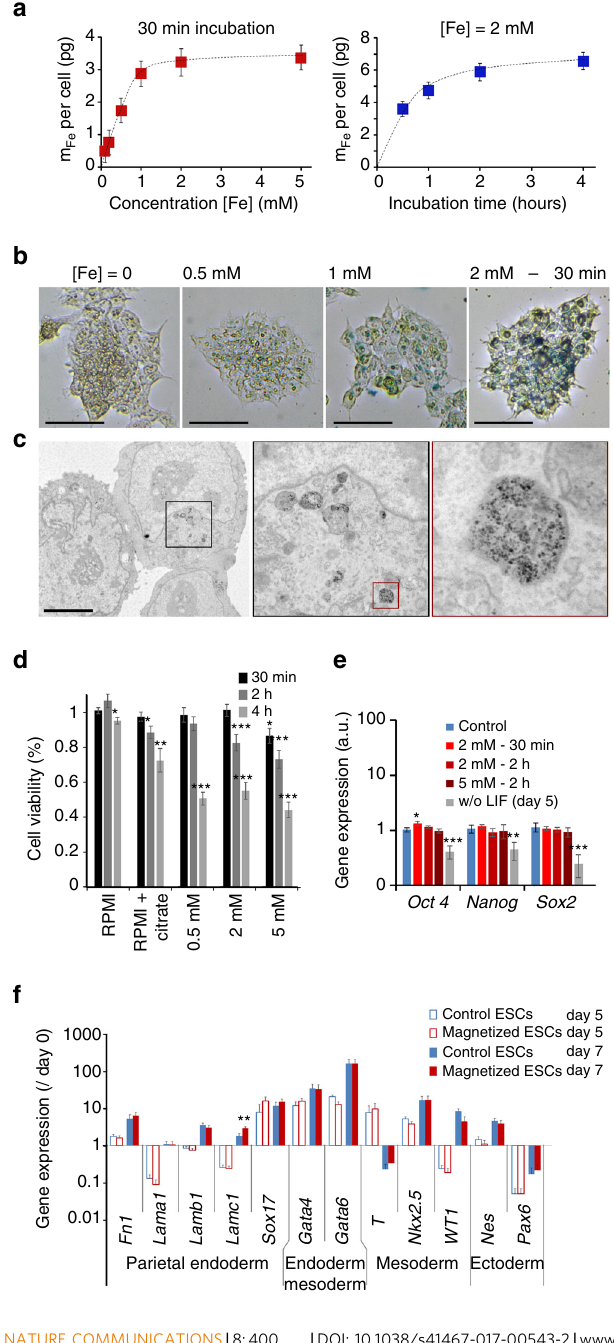
Fig. 2 Optimization of embryonic stem cell (ESC) magnetic labeling. a Magnetic labeling of ESCs at different extracellular iron concentrations (for a fi xed incubation time of 30 min) and during different incubation periods (for a fi xed iron concentration of [Fe] = 2 mM). b Perls ’ Prussian blue staining of ESCs after labeling with different concentrations of extracellular iron (between 0.5 mM and 2 mM), and a fi xed incubation time of 30 min. Scale bar : 250 µ m. c Transmission electron micrograph of ESC after labeling for 30 min at [Fe] = 2 mM (successive zooms of framed areas). Scale bar: 5 µ m. Nanoparticles are all located inside the lysosomes. d Cell viability testing using Alamar Blue detection of cell metabolic activity. Cell viability was calculated relative to the control (unlabeled cells